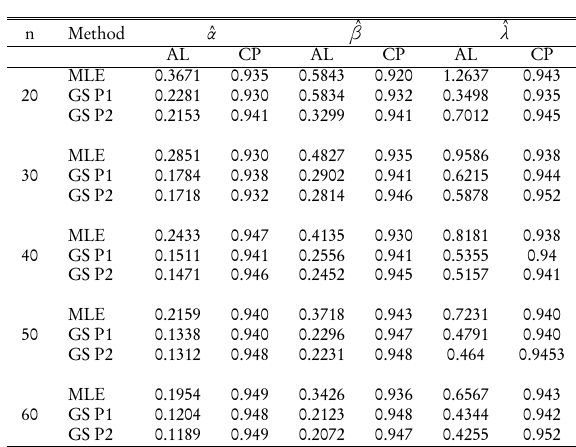
The average length (AL) and coverage probability (CP) of 95% asymptotic confidence and HPD credible intervals of parameters when α = 0.5, β = 0.5, λ =